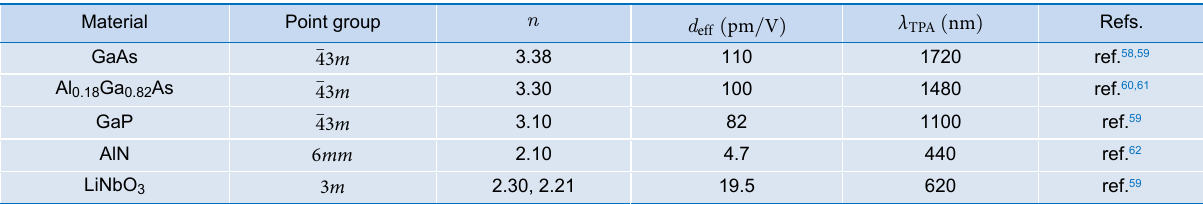
Table 1 | Most common materials for χ (2) nonlinear nano-optics. Refractive index n and second-order nonlinear coefficient d all refer to a wavelength λ = 1550 nm but for LiNbO 3 for which we consider λ = 1313 nm.